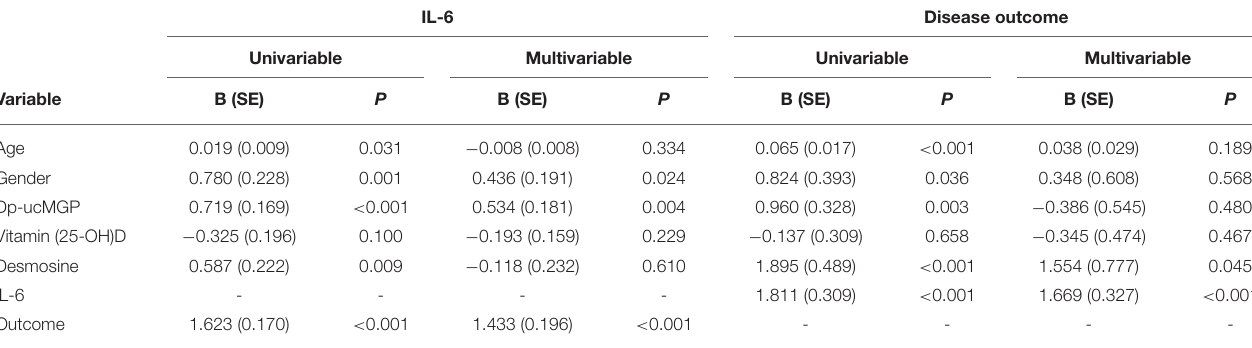
TABLE 2 | Univariable and multivariable analyses assessing factors associated to IL-6 levels and disease outcome. IL-6 Disease outcome Univariable Multivariable Univariable